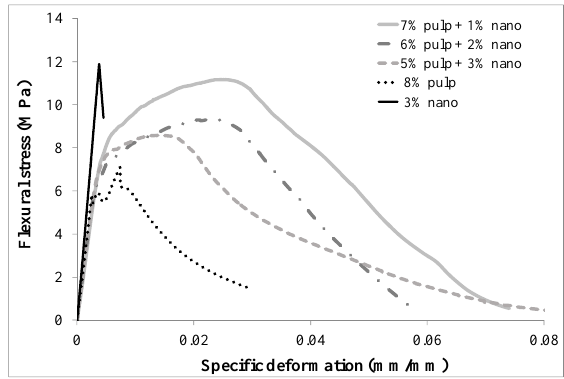
Figure 7. Typical stress ‐ strain curves of the composites with 3% of nanofibrillated cellulose, the hybrid composites with different content of pulp and nanofibrillated cellulose and composites with 8% of pulp at 8 days. The values of the modulus of rupture of the hybrid composites and of the composite reinforced with just 3% of nanofibrillated cellulose are significantly higher